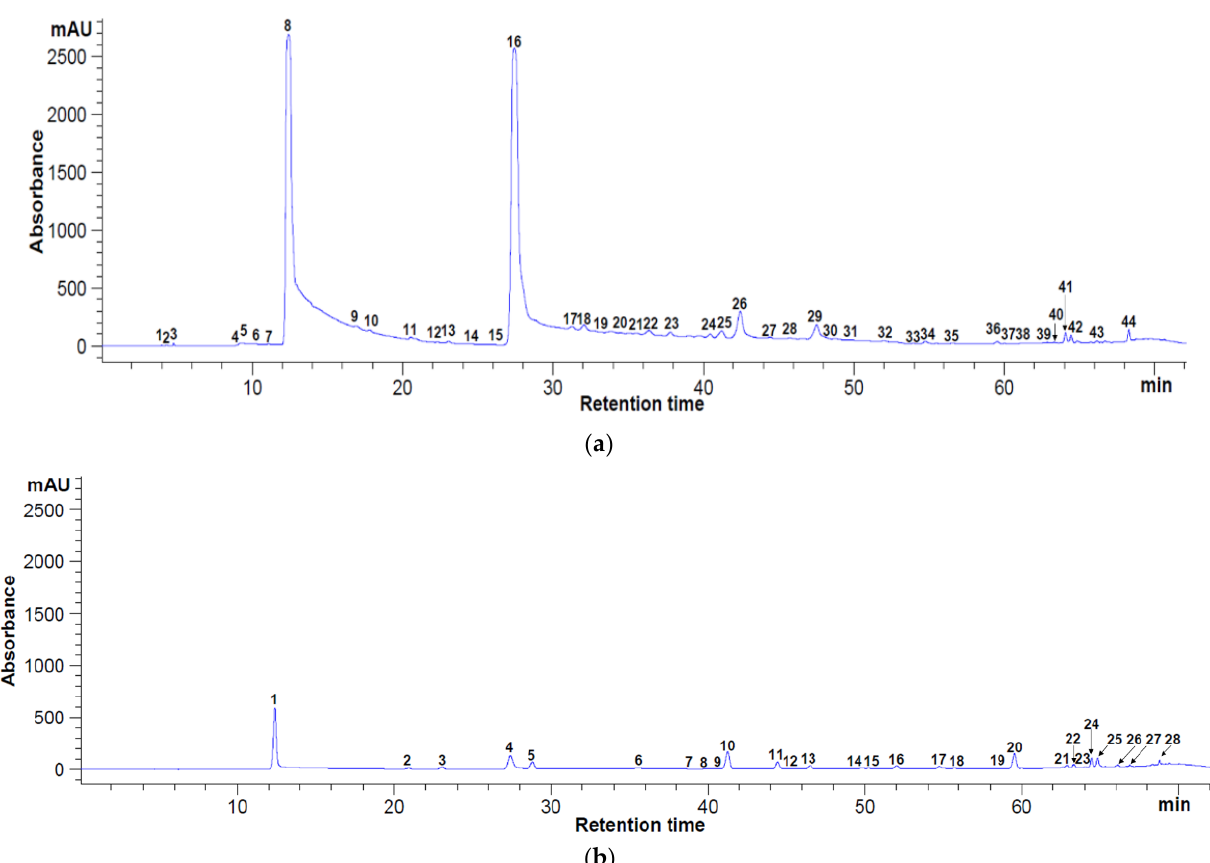
Figure 2. HPLC analysis for bounded polyphenolic compounds in freeze-dried apple pomace extract at 280 nm ( a ) and 320 nm ( b ). Peaks’ identification: ( a ): 5 — gallic acid, 21 — caffeic acid, 30 —